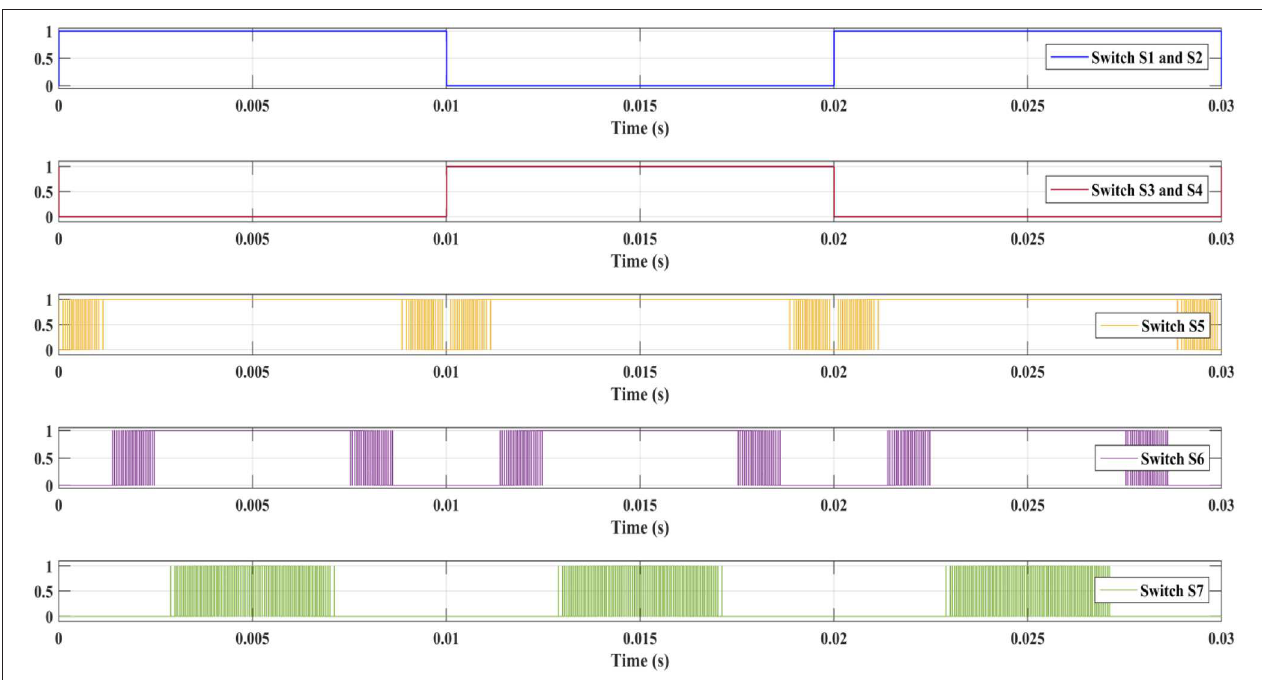
FIGURE 9 | Pulse sequence of DCL MLI.